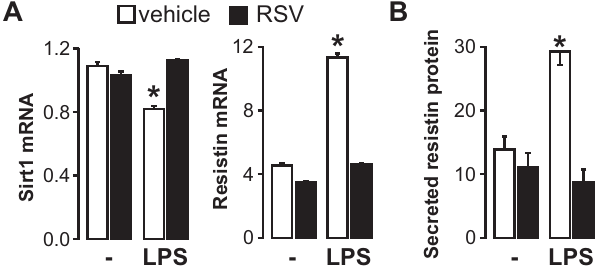
Figure 2. Activation of Sirt1 inhibits resistin expression in macrophages. A , Sirt1 and resistin mRNA levels in U937 macrophages treated for 24 h with LPS (1 m g/mL) and resveratrol (50 m M) or their respective vehicle. B , Secreted levels of resistin in U937 macrophages treated as in A. Bars are representative of 3 experiments done in triplicate. In all panels, * indicates a significant difference between groups.